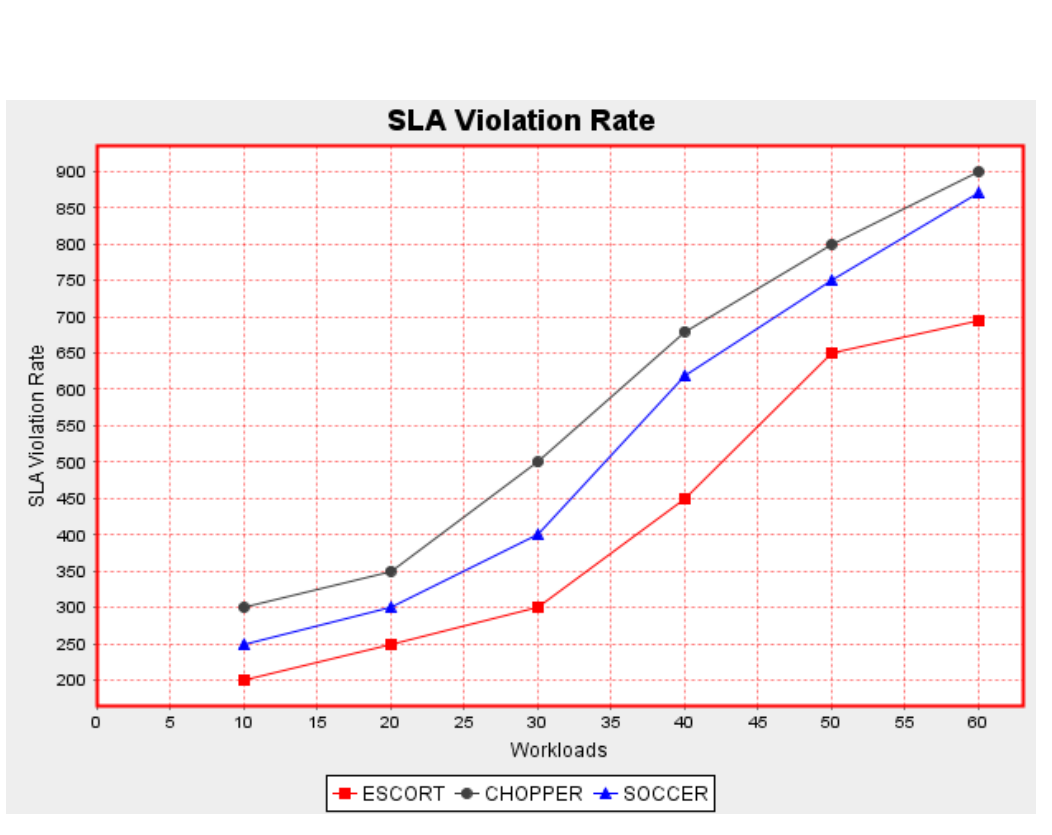
Figure 5. SLA violation